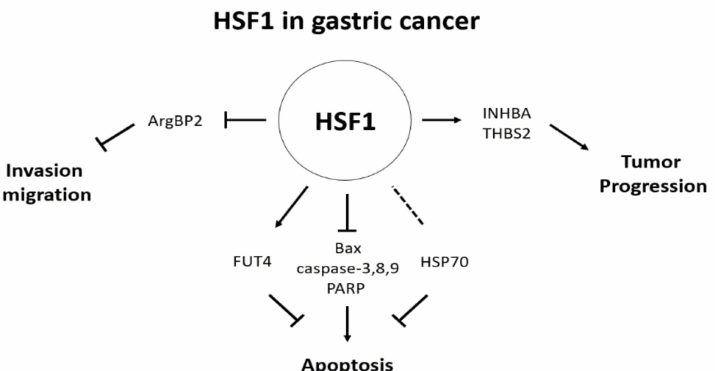
Figure 2. Various roles of HSF1 in gastric cancer. HSF1 has been shown to be involved in cell growth, apoptosis, migration, and invasion in gastric